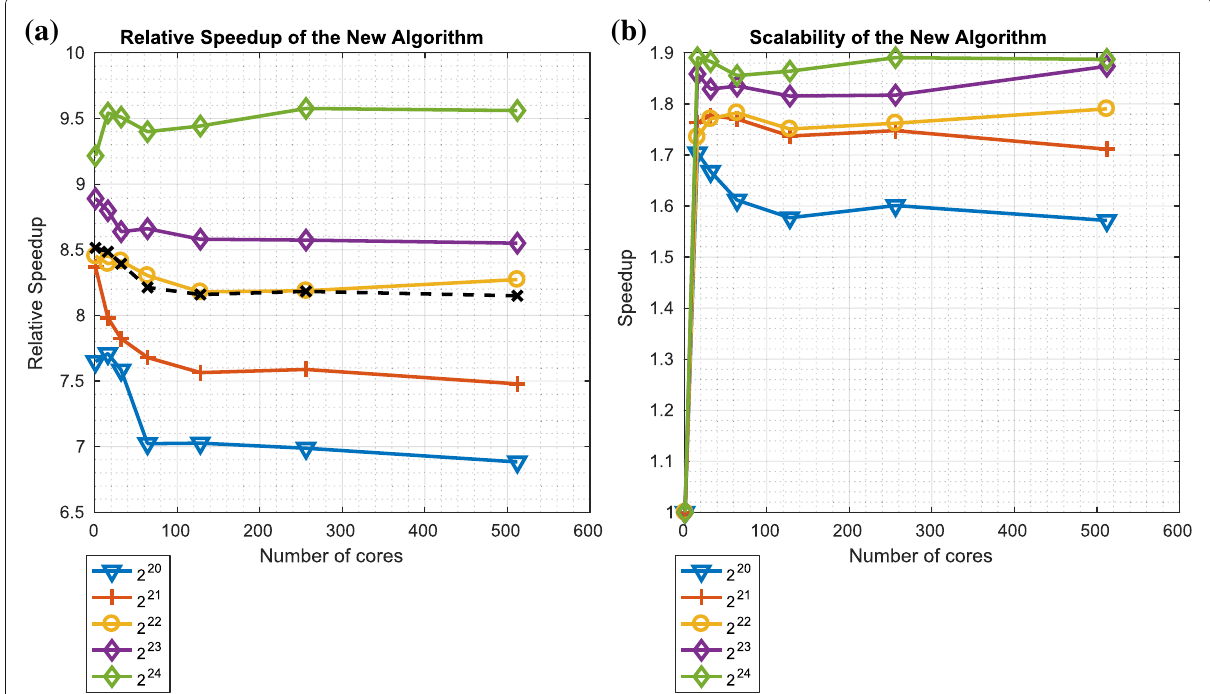
(cid:2) (cid:3) N ( log ) 2 variant of the redistribution component on 2 N P